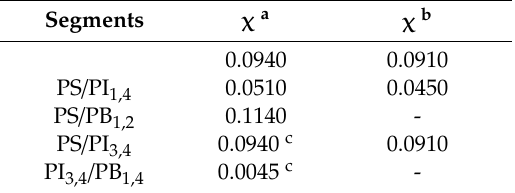
Table 2. Calculation of Flory–Huggins interaction parameter χ